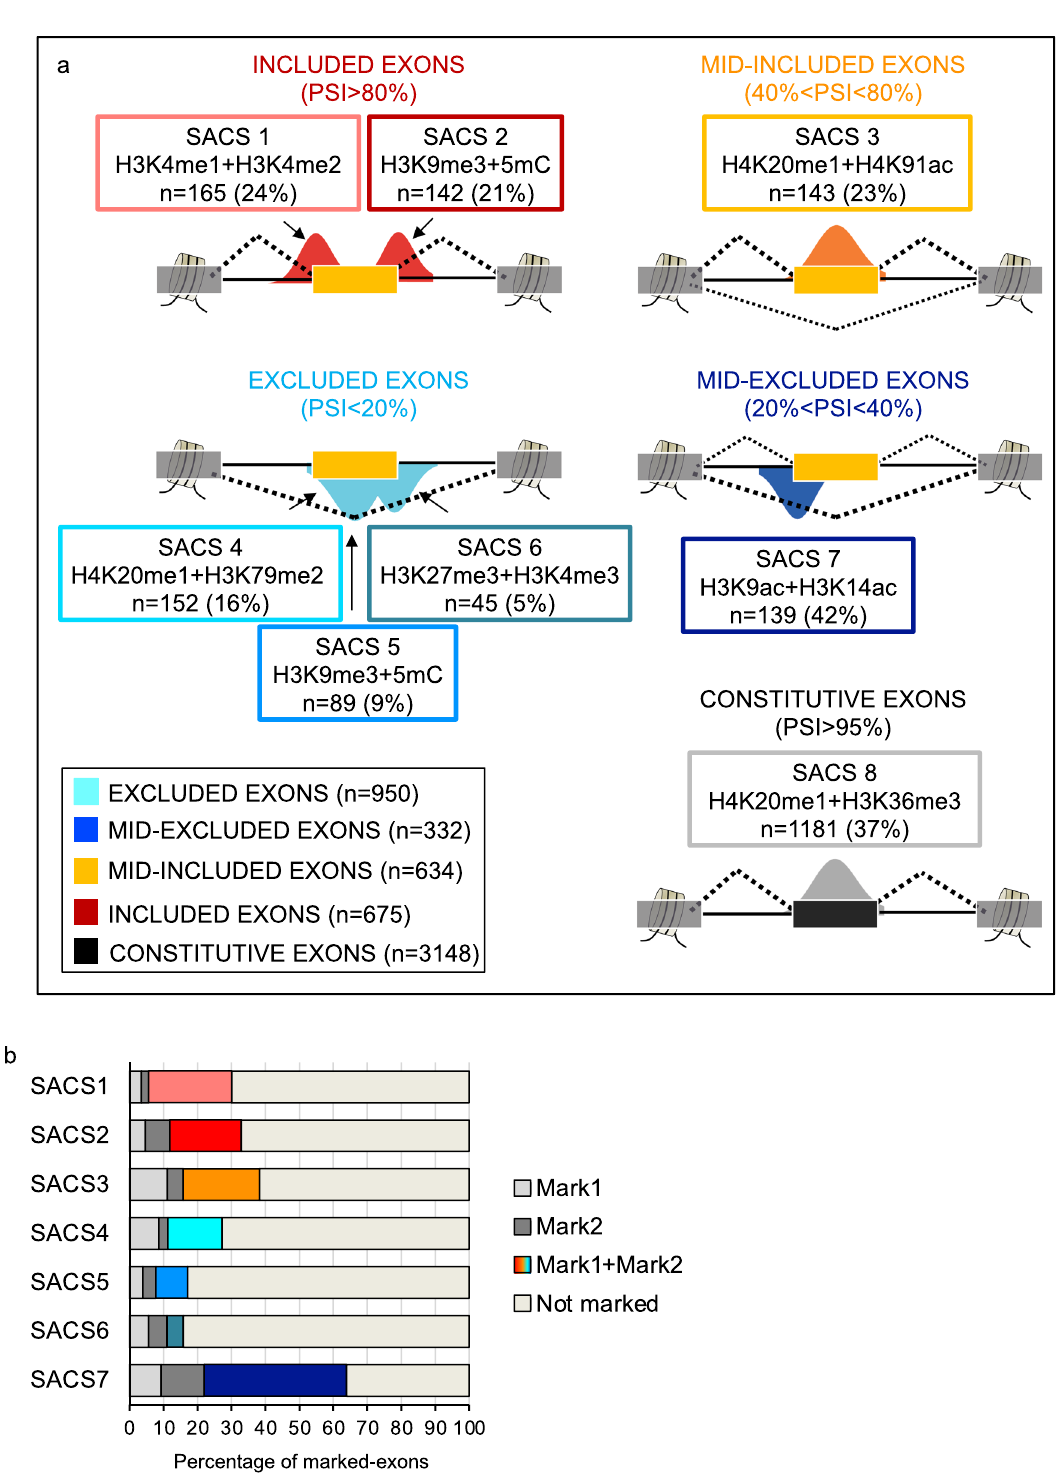
Fig. 2 Splicing-associated chromatin signatures (SACS) in H1 hESCs. a Schematic representation of the seven combinations of chromatin modi fi cations (SACS) that differentially mark alternatively spliced exons. As controls, we used exons with randomised splicing levels and constitutive exons, which are exons always included in the mRNA, from the same genes as the alternatively spliced exons analysed. For each SACS, we specify the splicing group it is related to, the two co-enriched histone marks, the position of enrichment along the exon (represented by a peak) and the total number ( n ) of exons marked by the chromatin signature (in brackets the percentage of chromatin-marked exons respect the total number of exons analysed per group). b Percentage of alternatively spliced exons marked by the two chromatin modi fi cations de fi ning a SACS, just one of the two marks or none.